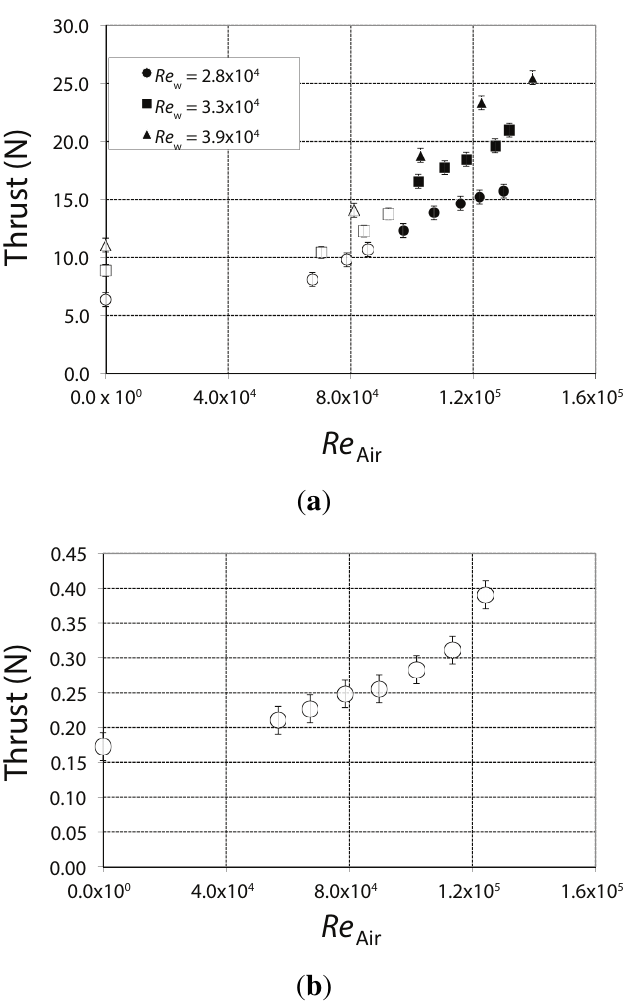
Figure 9. Thrust-plate measurements—Contoured SFE. ( a ) Mean thrust; ( b ) no water flow = 0 ( Re W